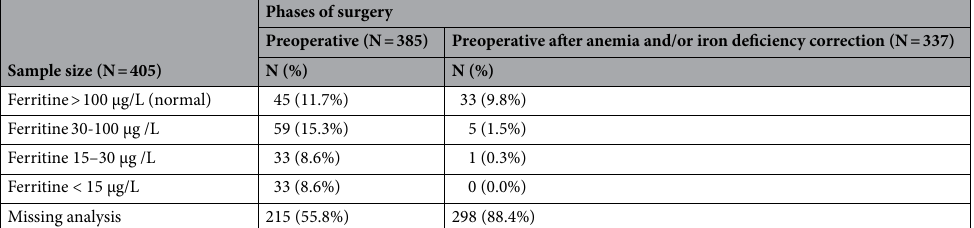
Table 3. Number of patients according the different values of serum ferritine at preoperative period and after the treatment of anaemia/ iron deficiency correction.